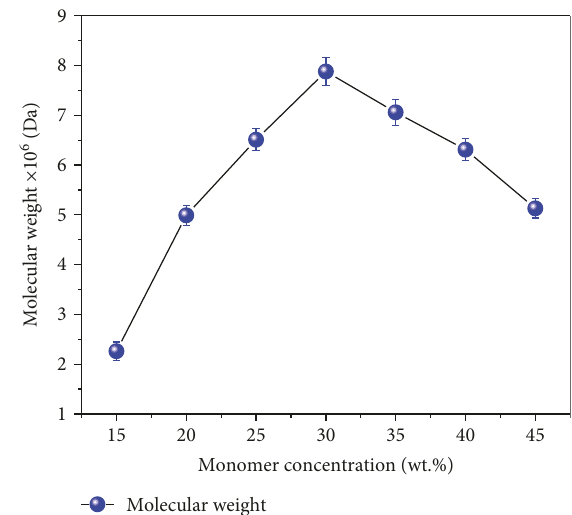
Figure 2: E ff ect of monomer concentration on the molecular weight of